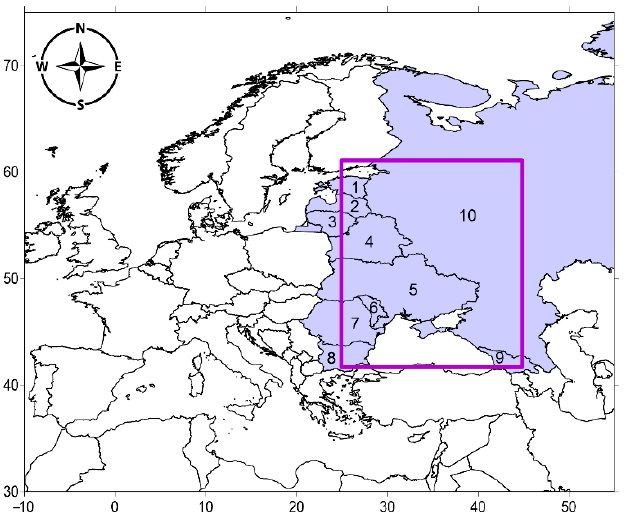
Figure 1. The study region (purple rectangle). Numbers correspond to the countries included in